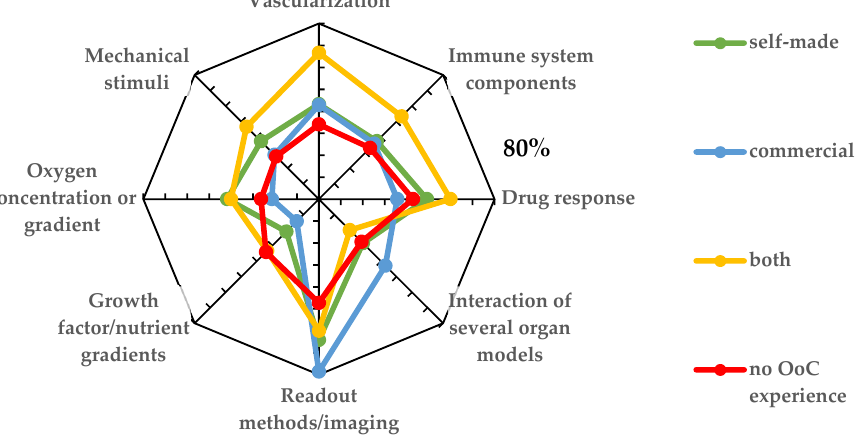
Figure 4. Desired features of OoC platforms are sorted by users of self-made and commercial platforms as well as by researchers with no OoC experience.